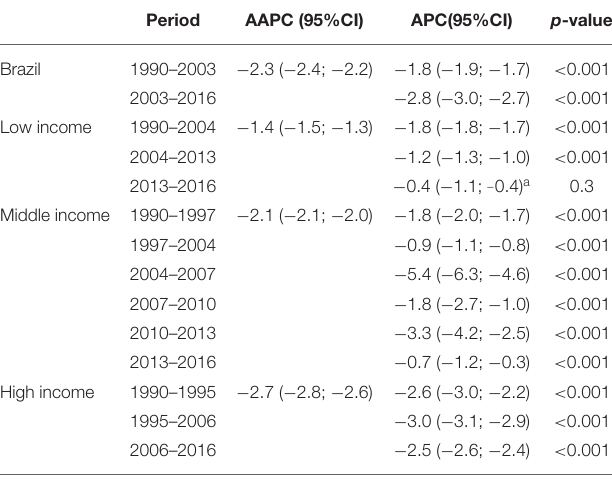
TABLE 2 | Estimates of temporal trend of specific mortality rates for stomach cancer according to cut-off points obtained through the joinpoint. 1990–2016. Period AAPC (95%CI) APC(95%CI) p -value